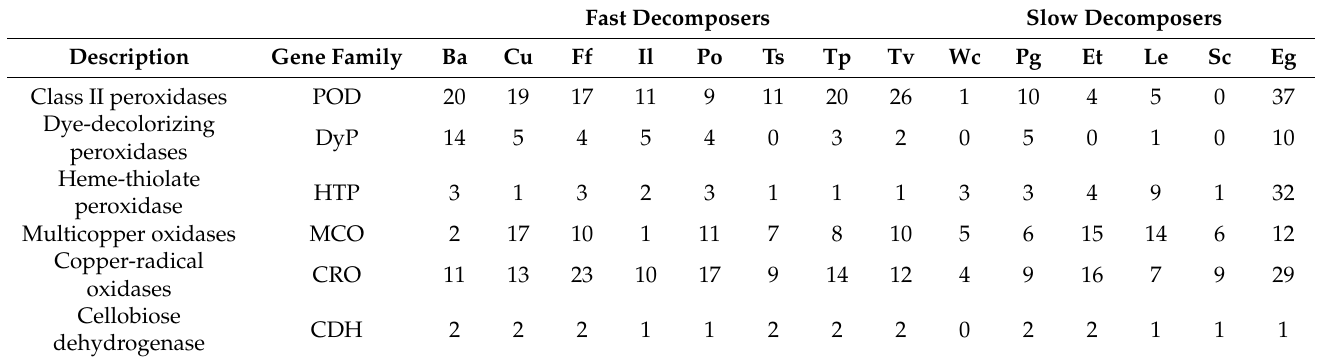
Table 3. The gene families of wood-decay redox genes in the genomes from the fourteen selected species. Ba ( Bjerkandera adusta) ; Cu ( Cerrena unicolor) ; Ff ( Fomes fomentarius) ; Il ( Irpex lacteus) ; Po ( Pleurotus ostreatus) ; Ts ( Trametes sanguinea) ; Tp ( Trametes pubescens ; Tv ( Trametes versicolor) ; Wc ( Wolfiporia cocos) ; Pg ( Phlebiopsis gigantea) ; Et ( Echinodontium tincorium) ; Sc ( Schizophyllum commune) ; Eg ( Exidia glandulosa) . Numbers indicate the number of genes in each gene